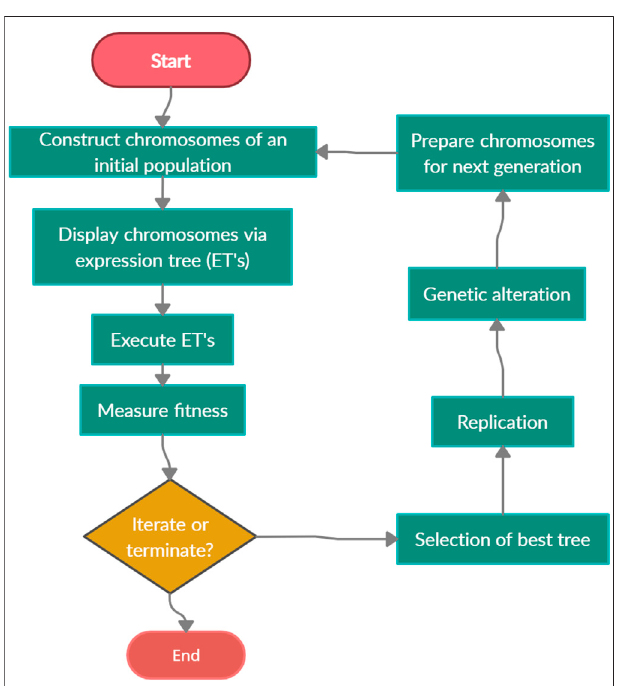
FIGURE 1 | Architectural fl owchart of GEP